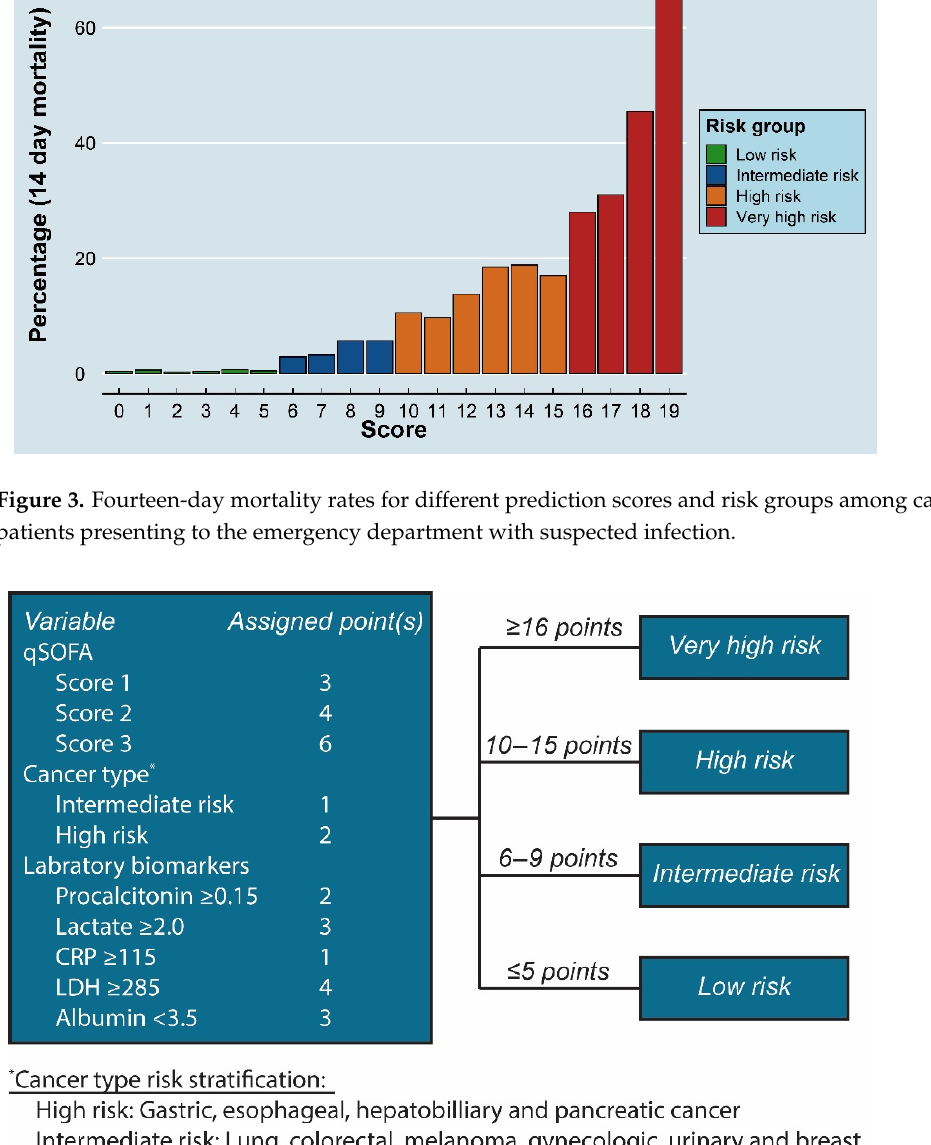
Figure 4. Algorithm of the final prediction score for 14-day mortality among cancer patients presenting to the emergency department with suspected infection. qSOFA, quick sequential organ failure assessment; CRP, C-reactive protein; LDH, lactate dehydrogenase.